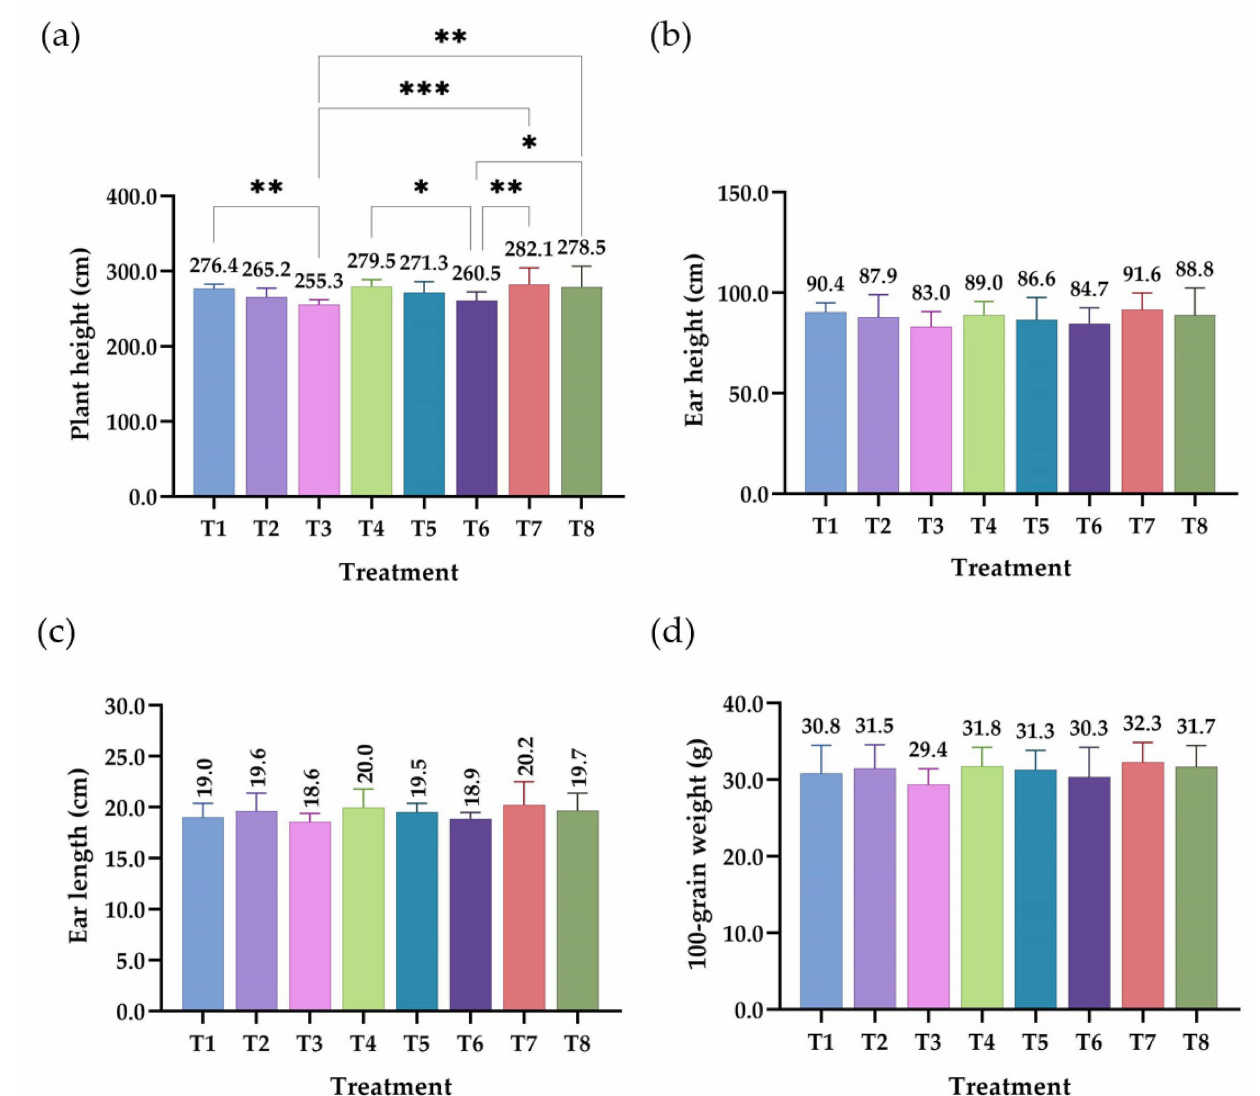
Figure 8. Agronomic performances of transgenic maize SCB-29 between different treatments. ( a ) Plant height. ( b ) Ear height. ( c ) Ear length. ( d ) 100-grain weight. T1, SCB-29 with glyphosate at 900 g a.e. ha − 1 . T2, SCB-29 with glyphosate at 1800 g a.e. ha − 1 . T3, SCB-29 with glyphosate at 3600 g a.e. ha − 1 . T4, SCB-29 with glufosinate at 900 g a.e. ha − 1 . T5, SCB-29 with glufosinate at 1800 g a.e. ha − 1 . T6, SCB-29 with glufosinate at 3600 g a.e. ha − 1 . T7, SCB-29 with manual